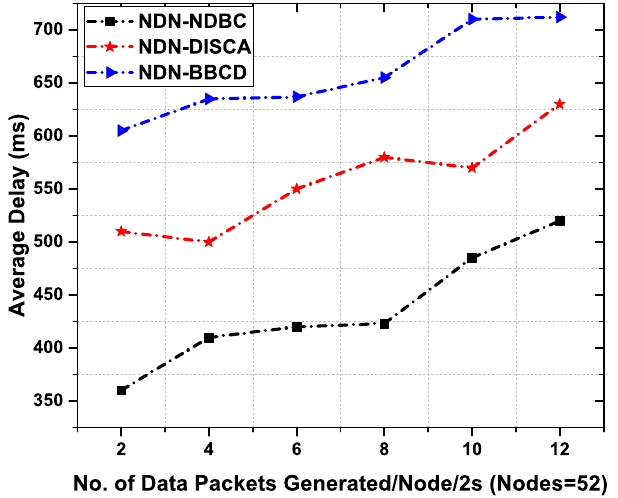
Figure 11. Average Delay as a function of number of data packets generated per 2